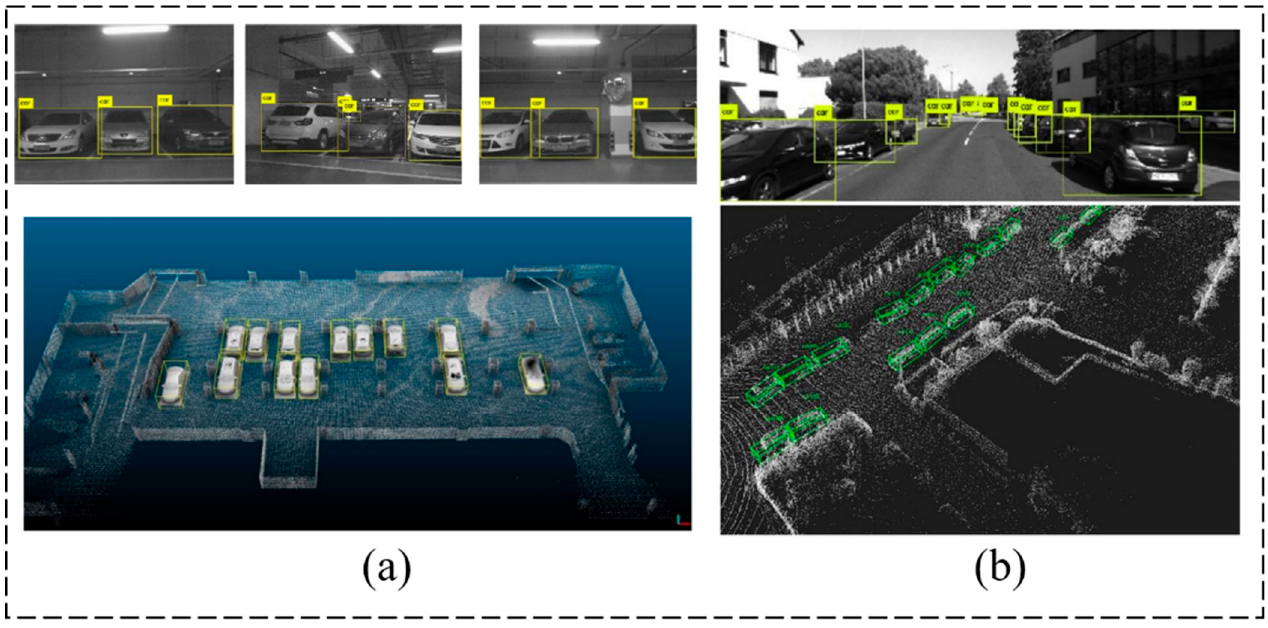
Figure 6. Object detection via camera and LiDAR infusion for an autonomous vehicle (AV) using simultaneous localization and mapping (SLAM) technique: ( a ) 2D object detection; ( b ) 3D object detection [50]. Table 1. Demonstration of the various factors that influence the performance of cameras [51].